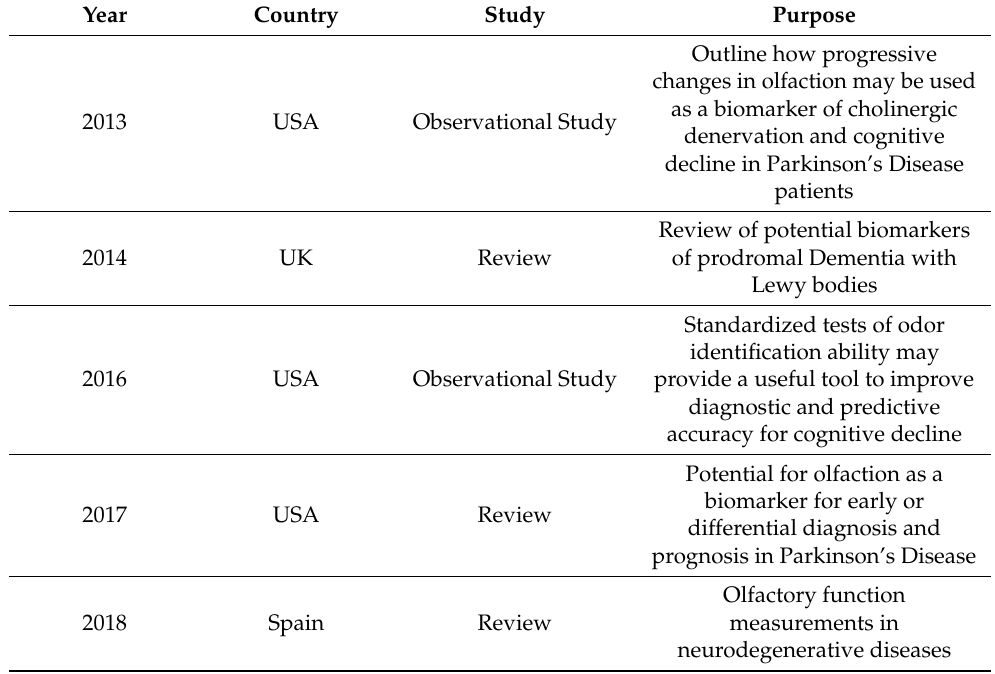
Table 1. Main studies discussed in the review (see text for description) .